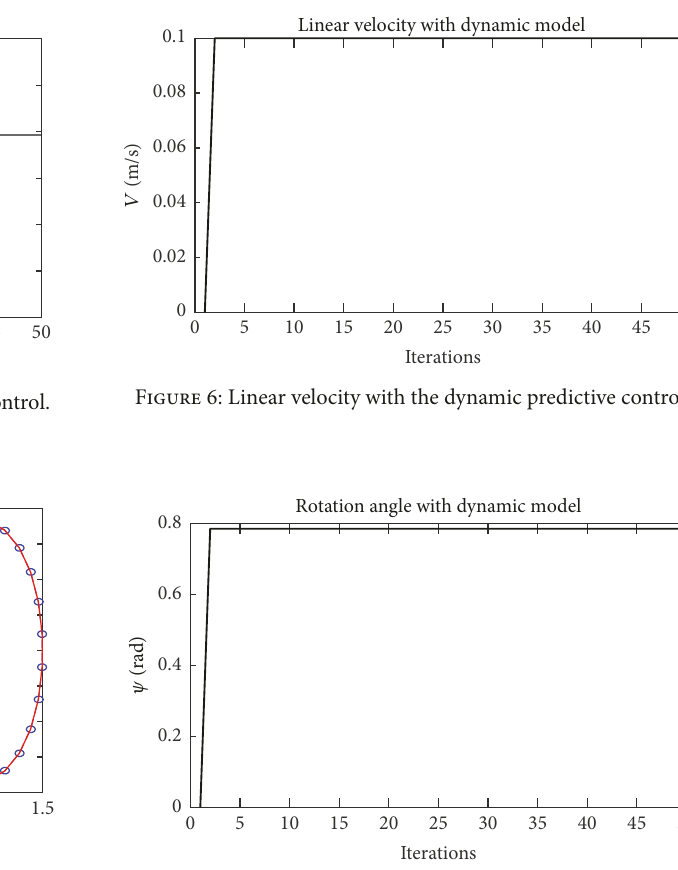
Figure 7: Rotation angle with the predictive dynamic